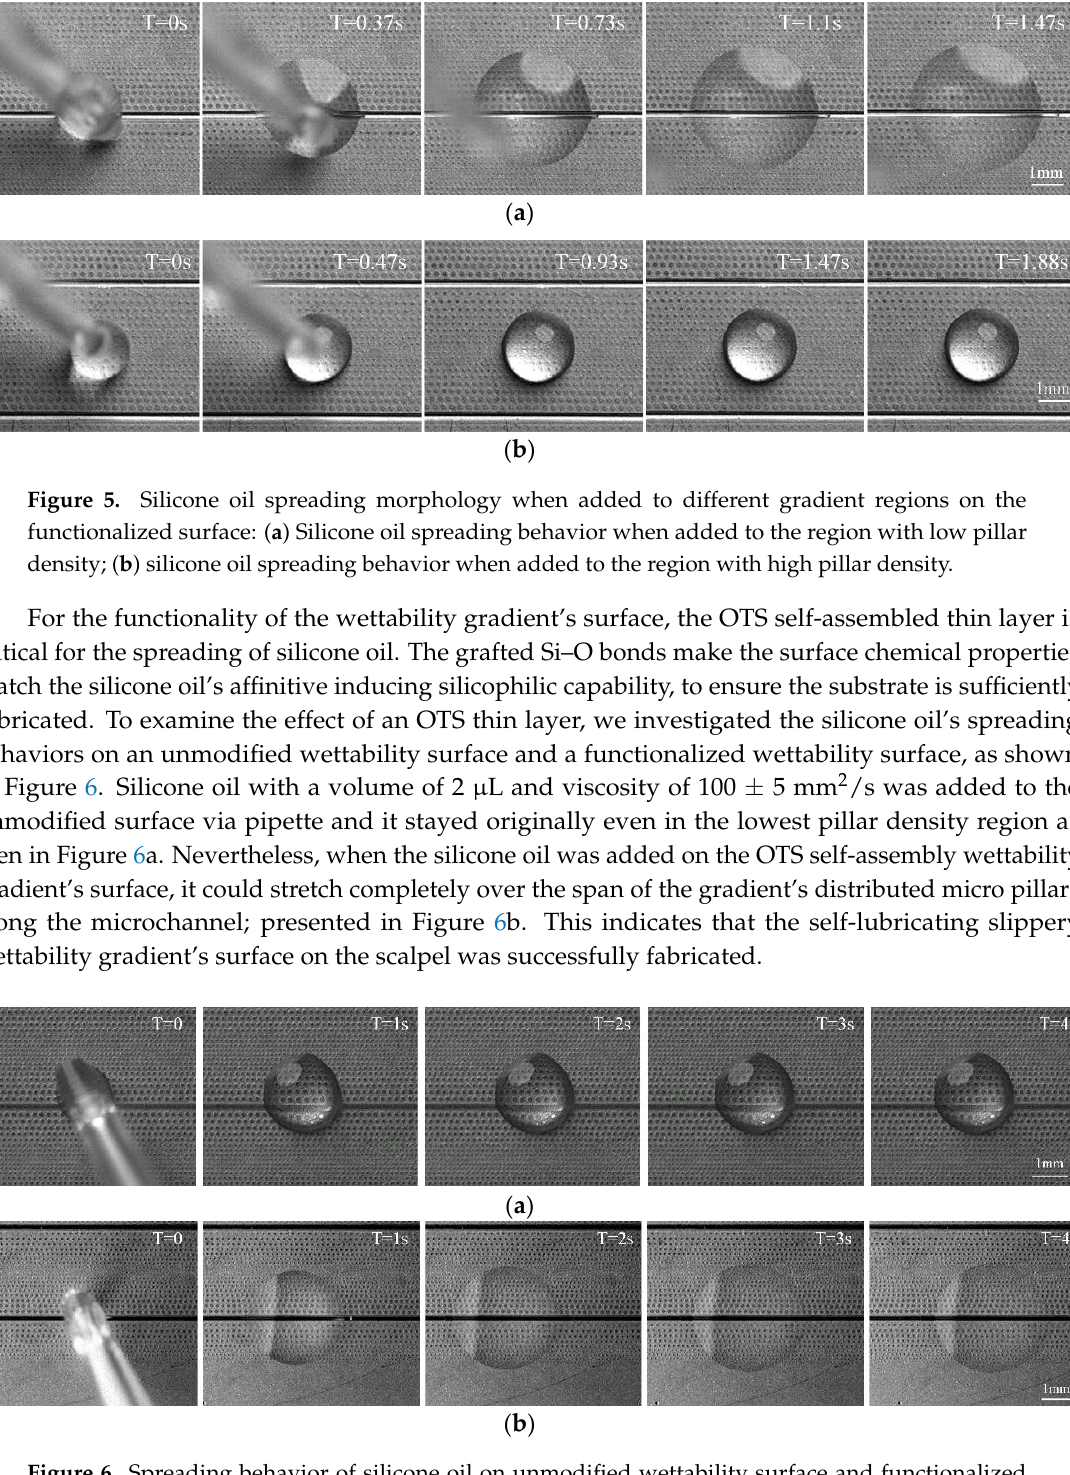
Figure 6. Spreading behavior of silicone oil on unmodified wettability surface and functionalized wettability surface: ( a ) Silicone oil spreading on unmodified wettability surface; ( b ) silicone oil spreading on functionalized wettability surface.